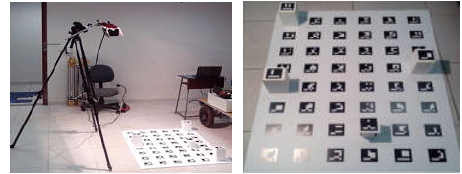
Figure 2. (a) Calibration set up, with the camera static and a targets plate; (b) example of one acquired image.